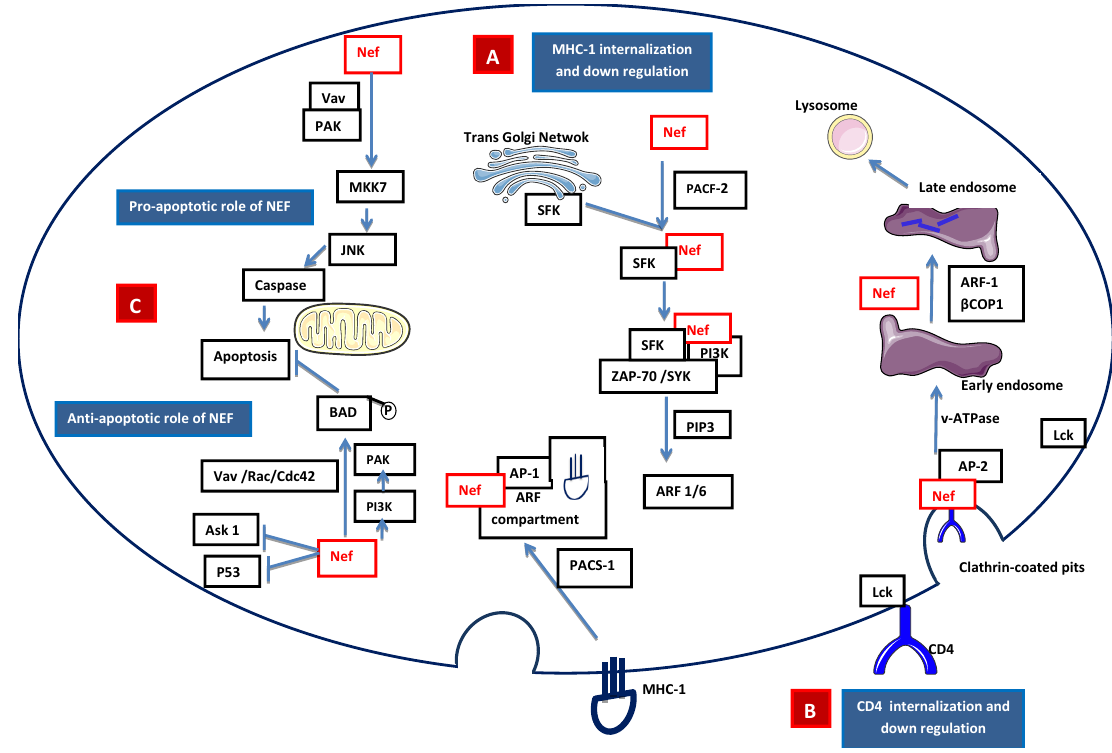
Figure 3. Signaling model of Nef-mediated ( A) apoptosis/anti-apoptosis, (B) down-regulation of expression of MHC class I molecules, and ( C) down-regulation of the expression of CD4 molecules. A. Internalization of MHC-I: Nef accelerates the endocytosis of MHC class I molecules through PI3K-dependent activation of ADP ribosylation factor 6 (ARF6)-mediated endocytosis. First, the Nef binds PACS-2 and targets to the late Golgi/TGN; at the TGN, Nef binds and activates a TGN-localized SFK. The activated Nef–SFK complex, which leads to the signal transduction pathway recruiting and activating ZAP-70/Syk, then binds to a class I PI3K. The activated PI3K causes the accumulation of phosphatidylinositol-3,4,5-triphosphate (PtdInsP (PIP3) on the inner leaflet of the plasma membrane. PIP3 recruits the ARF6 guanosine exchange factor (ARF6-GEF) to the plasma membrane. Nef mediates the internalization of MHC-I from the plasma membrane to an ARF-6 endosomal compartment. The endocytosed MHC-I forms a complex with Nef and AP-1 via phosphofurin acidic cluster sorting protein 1 (PACS1). B. Internalization of CD4: Lck disassociates from the cytoplasmic tail of CD4 and Nef is attached to the cytoplasmic tail of CD4 within clathrin-coated pits through the interaction of adaptor protein 2 (AP-2) and vacuolar ATPase (v-ATPase). This leads to the internalization of CD4 into the early endosome. During the formation of the late endosome, Nef intacts with βCOP1 and through ARF- 1, which targets CD4 to the lysosomal degradation. C. Apoptotic role of Nef: Intrinsic Nef signals localized on plasma membrane activate MAP kinase kinase 7 (MKK7) and c-Jun N-terminal kinase (JNK) to induce caspase-dependent apoptosis, while the anti-apoptotic pathway is mediated by Fas cell surface death receptor (FAS) and tumor-necrosis factor receptor (TNFR) by inhibiting the apoptosis signal-regulating kinase (ASK1) and P53. Nef-mediated p21-activated kinase (PAK) activation involves PI3K, which acts upstream of PAK. Nef-associated PI3K and PAK phosphorylate the pro-apoptotic Bad protein to inactivate Bad, thus blocking the apoptosis mediated by